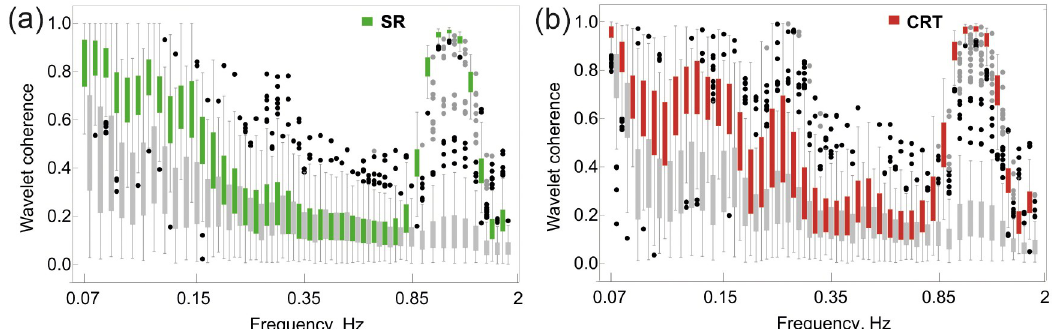
Fig 4. Box whisker diagram describes the wavelet coherence of oscillation of blood flow compared with the surrogate data (plotted by gray) during SR (a) and CRT (b). Dots indicate outliers.